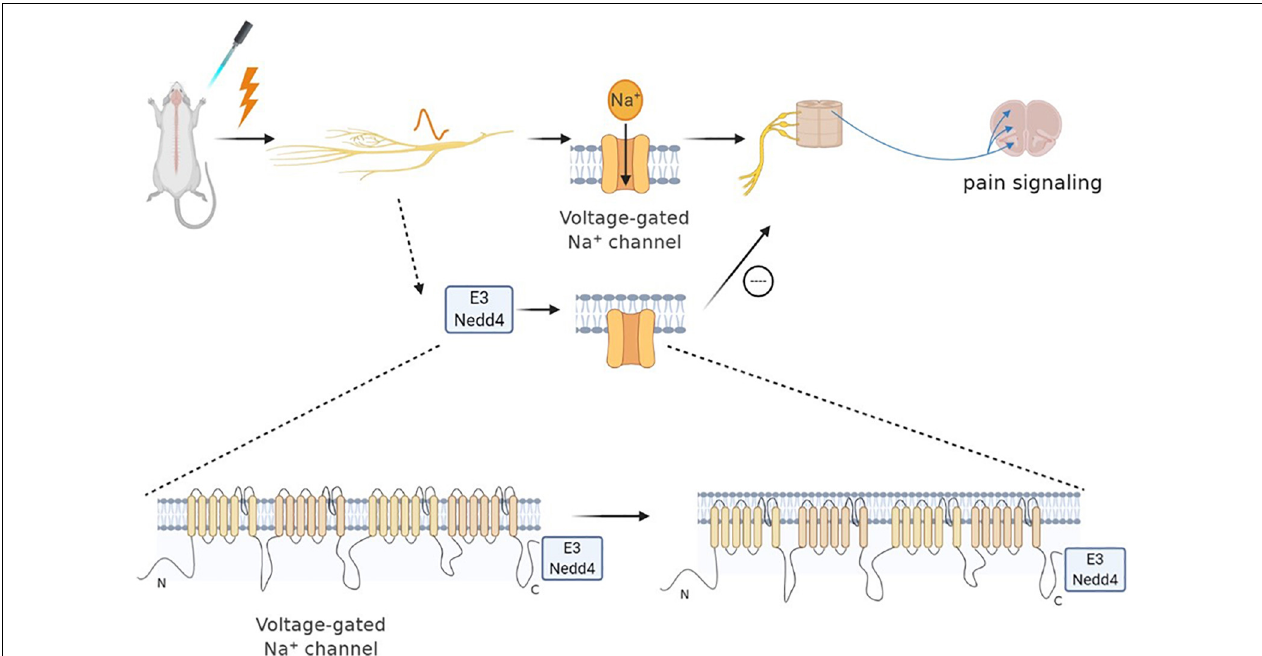
FIGURE 1 | Neural precursor cell expressed developmentally downregulated protein 4 (NEDD4) family of E3 ubiquitin ligase can effectively regulate Nav channels. Sodium channels play an important role in neuropathic pain. When nociceptors are activated, Nav1.7 and Nav1.8 are upregulated, leading to pain. The NEDD4 family of E3 ubiquitin ligase can react on sodium ion channels to ubiquitinate them and promote the channel endocytosis. Specifically, NEDD4 ubiquitin ligase can react with the PY motif at the end of the C subunit of each Nav subtype, thereby regulating the expression of the Nav channel, as well as the current density and neuronal excitability. Therefore, the pain signal of sensory neurons can be reduced indirectly by regulating the activity of